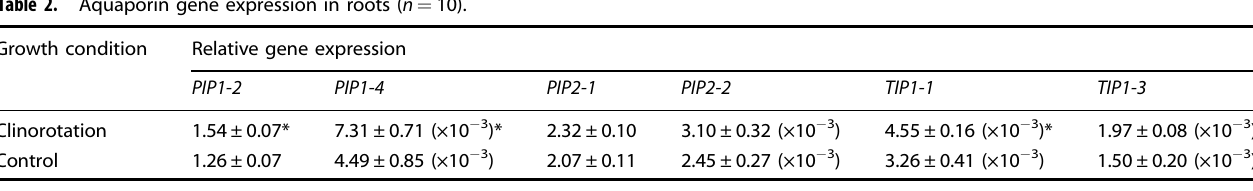
Fig. 1 Mung bean seedlings grown under clinorotaion and control. a , b Visible images of seedlings. The cotyledon, stem, and root sections were marked by red. ( c , d ) The NIR images of same seedlings. The color bar indicates second derivative intensity at 1418 nm. The upper seedlings were grown under clinorotation and bottom seedlings were grown under the control conditions. Table 2. Aquaporin gene expression in roots ( n =